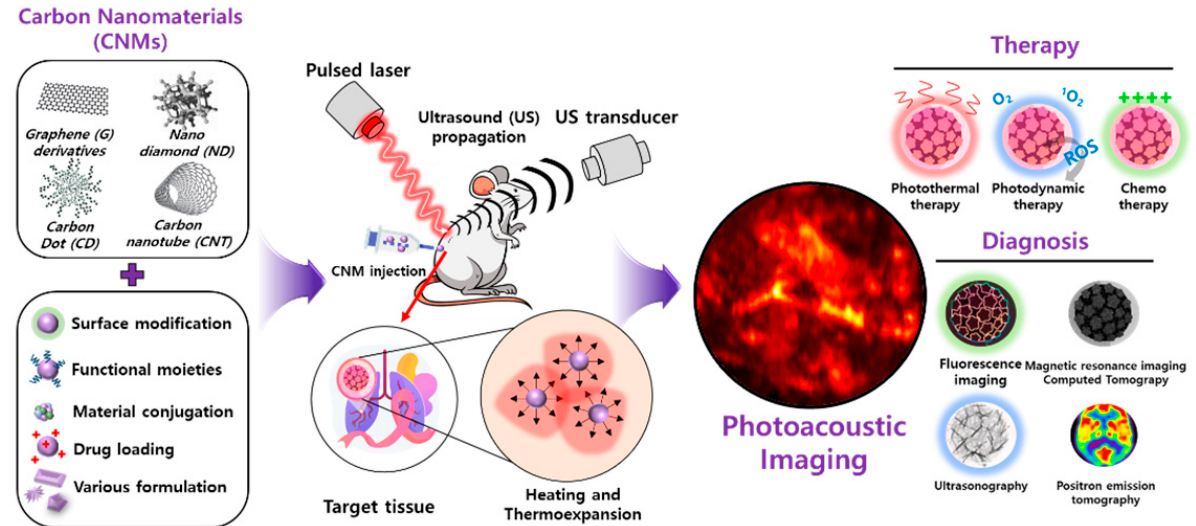
Figure 1. Illustration of functionalized carbon nanomaterial for photoacoustic imaging and a multimodal theragnostic probe.